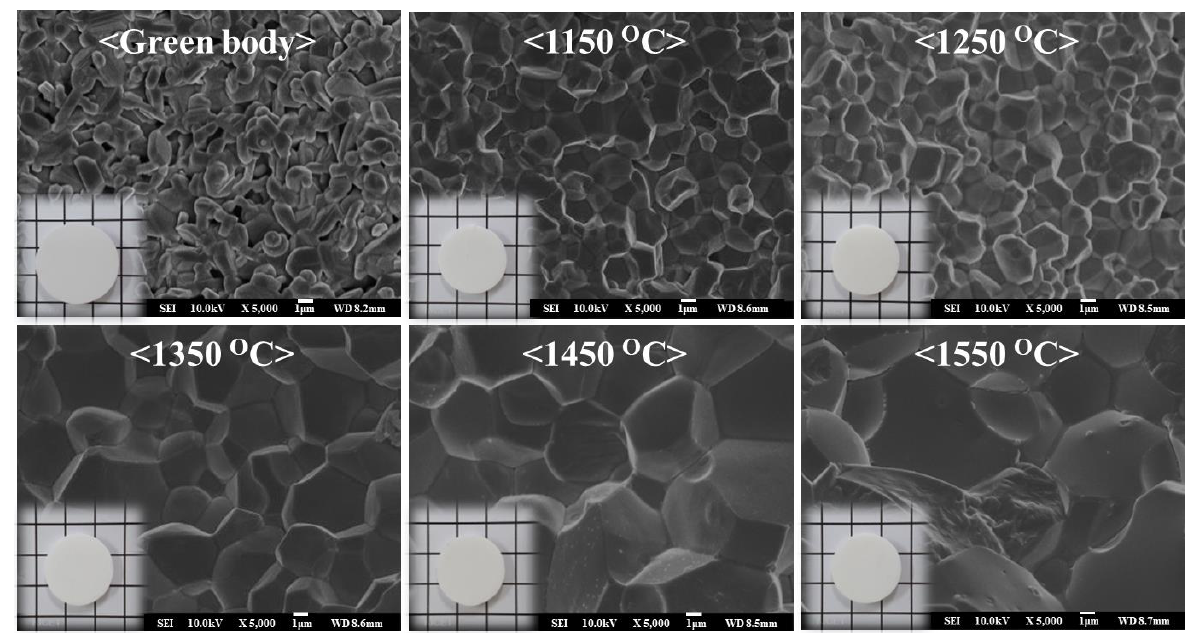
Figure 3. XRD patterns of 3YSZ 3D-printed sintered body according to sintering temperature.